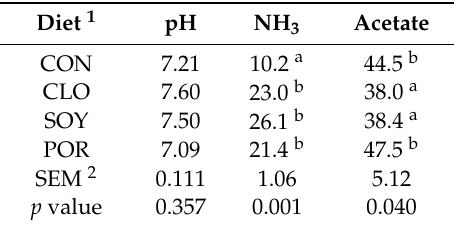
Table 8. Average values of pH, concentration of ammonia (mg / 100 mL) and of acetate (mmol / L) in the rumen of sheep fed the experimental diets in in vivo Experiment